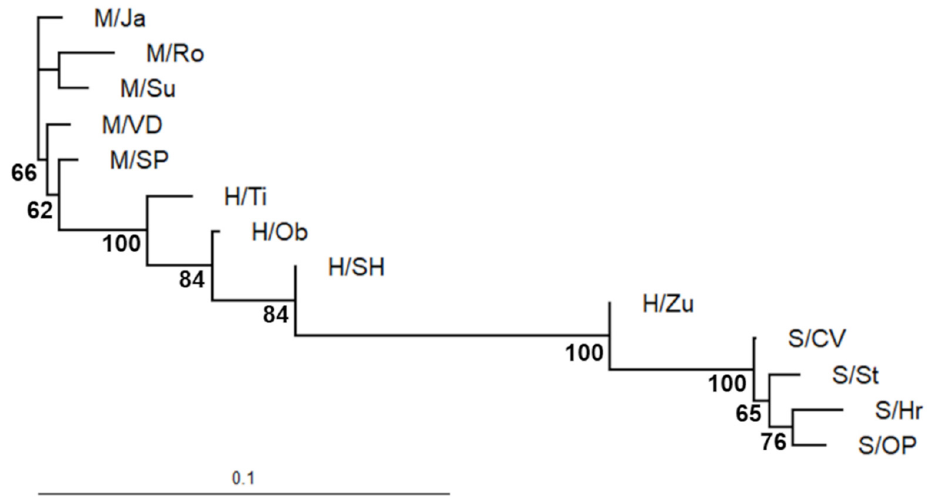
Figure 5. Neighbor ‐ joining phylogram showing phylogenetic relationships among studied popula ‐ tions (pop. abbreviations in Table 1). The tree relies on the same distance matrix as in UPGMA clus ‐ tering. Bootstrap support >50% is shown.